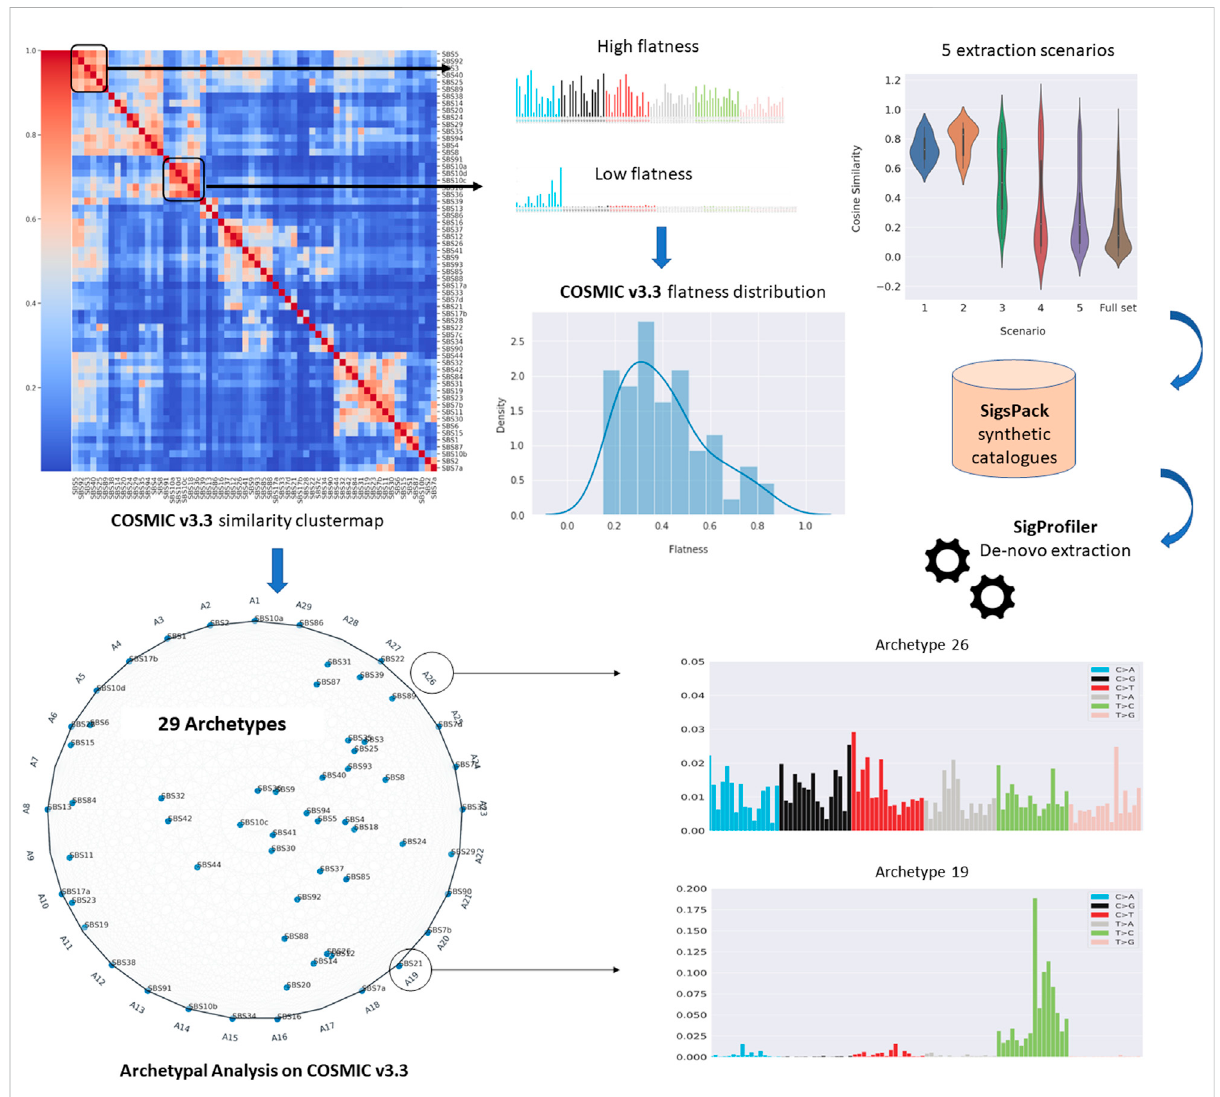
FIGURE 1 Summary of the analyses performed in this study. Firstly, we systematically assessed to which extent the extraction of the newest version of COSMICsignatures(v3.3)canbeaffectedbythehighsimilarityamongthesignaturesinthesamecatalogue,thelevelof fl atnessofthesignaturesand the number of available samples, assessing the de novo extraction across fi ve different scenarios (upper panel). Then, Archetypal Analyses was applied to provide a compact representation of the current catalogue by prioritising the identi fi cation of those pro fi les representing extreme patterns in the data so that all the observations can be reproduced as mixtures of their extremes (lower